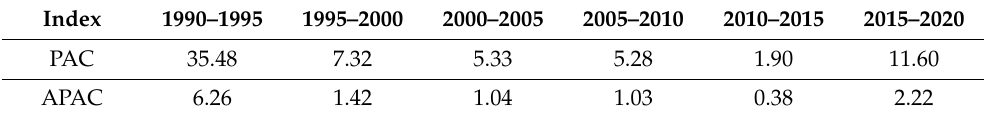
Figure 12. Glacial lake histograms and line chart areas in five mountain ranges from 1990 to 2020. Table 2. PAC and APAC values of glacial lakes in each period from 1990 to 2020.